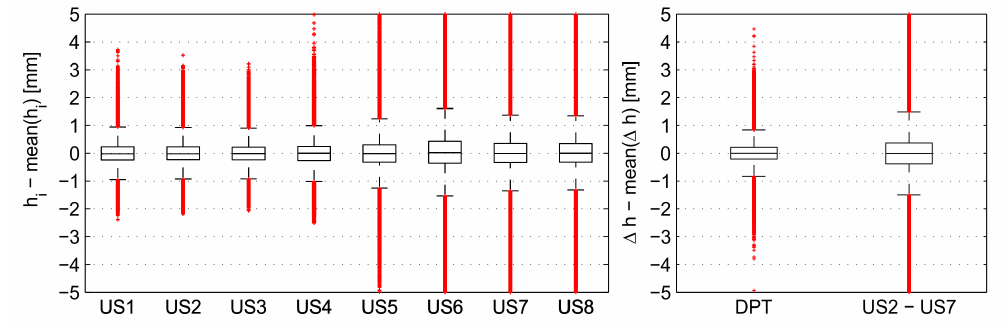
Figure 3. Analysis of the individual measured value standardised by the mean value of each geometry set-up: water depth at measurement points US1–US8 with ultrasonic sensors ( left ); and differential pressure transmitter (DPT) and difference between US7 and US2 ( right ).